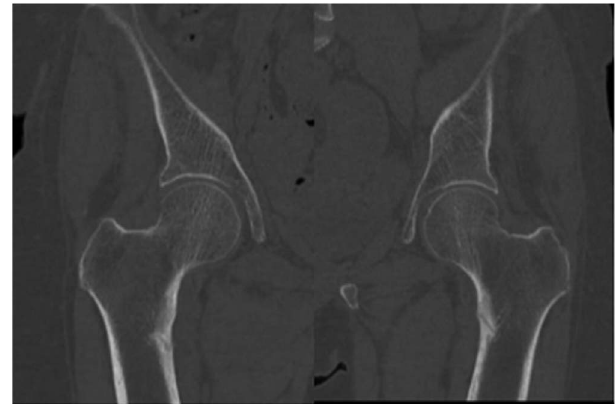
Figure 2. CT scan of both